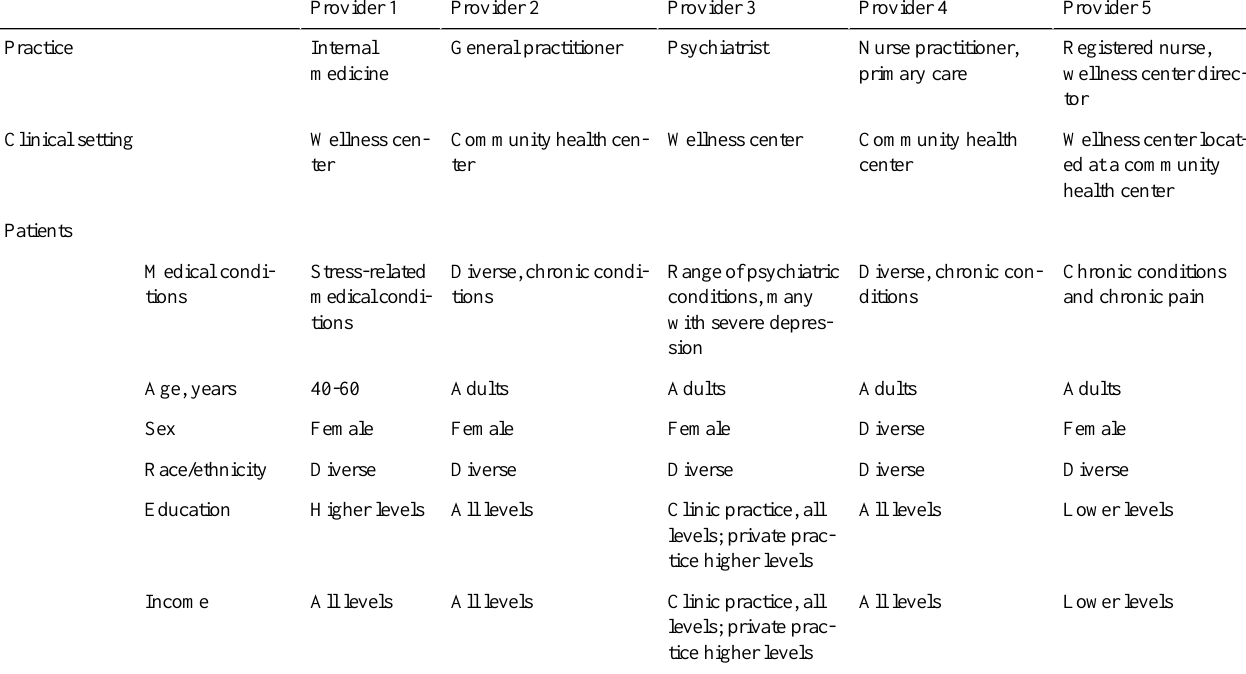
Table 2. Provider sample characteristics and the types of patients they